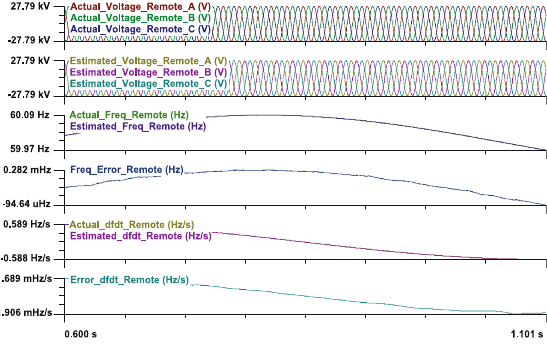
Fig. 22 Estimation results of frequency and the rate of frequency change based on